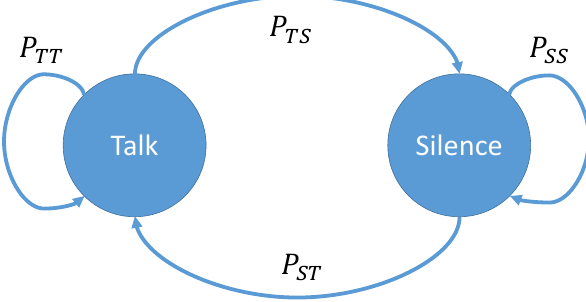
Figure 7. Markov chain modelling the source emission of zero and non-zero